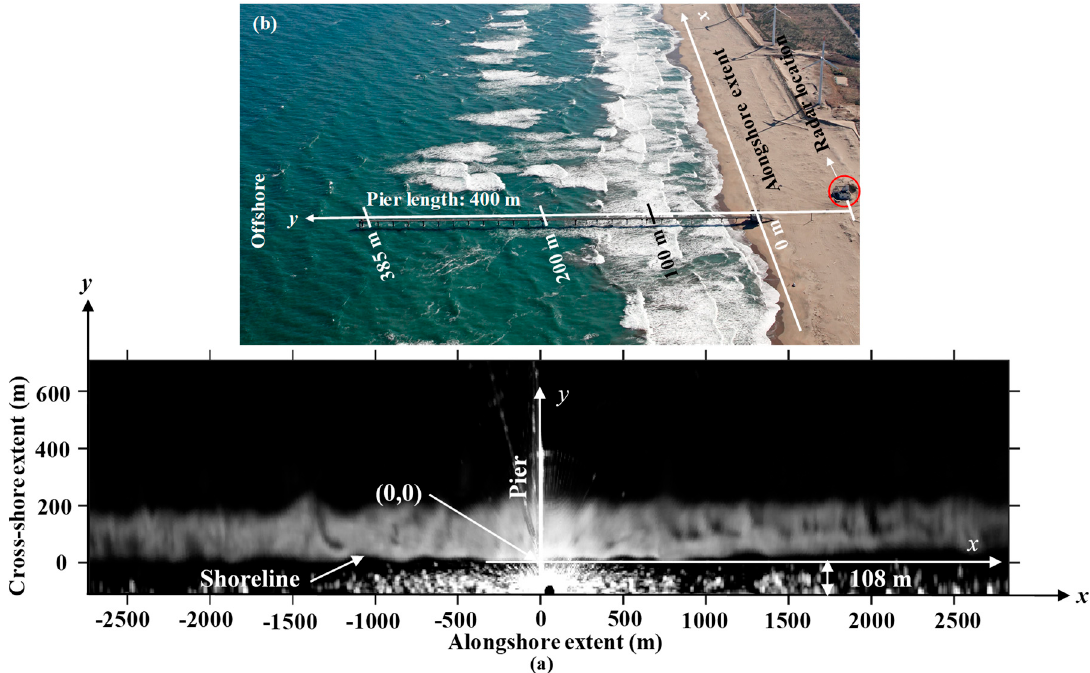
Figure 3. ( a ) The time-averaged X-band radar echo image and coordinate system (16 April 2005 at 12:00) and ( b ) the aerial view of the research pier. Survey data are measured along the pier from radar − 110 m to 385 m.